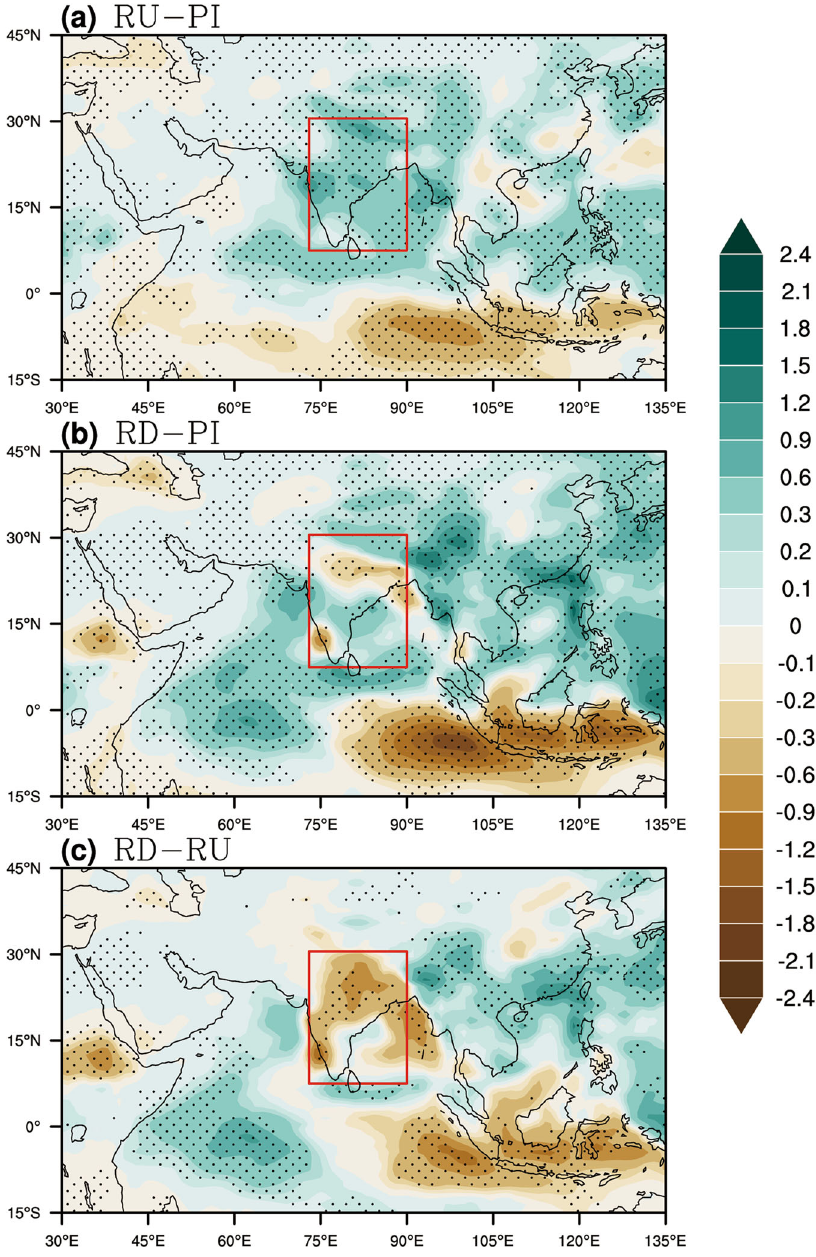
Fig. 3 The rainfall response (unit: mm day − 1 ) to the CO 2 forcing. The RU ( a ) and RD ( b ) periods rainfall anomalies compared to PI. c Difference in rainfall between the RU (20 – 60) and RD (220 – 259) periods. Black dots in ( a , b ) denotes the regions where more than 70% ensemble members agree with the sign of the MME. The regions denoted by the black dots in ( c ) indicate where the rainfall difference between the RU and RD periods are statistically signi fi cant at a 90% con fi dence level and more than 70% ensemble members agree with the sign of the MME. The red rectangles highlight the SASM